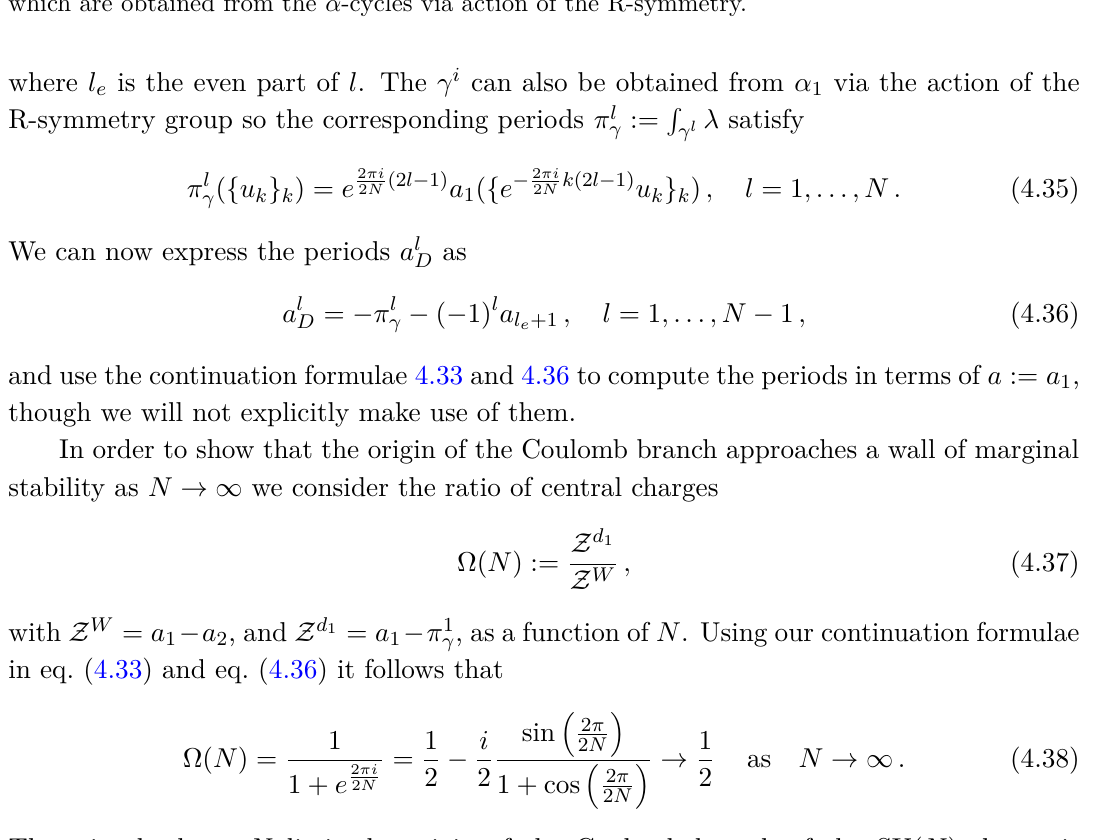
Figure 13 . Same setup as in figure 12 but instead of the β -cycles we depict the γ -cycles (in green) which are obtained from the α -cycles via action of the